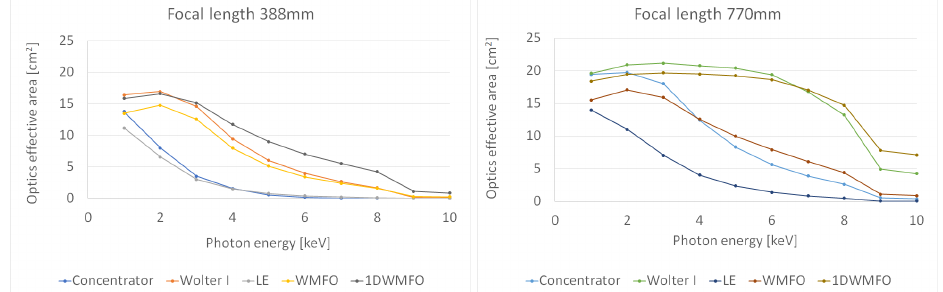
Figure 10. X-ray spectrometer optics effective area calculation for particular diameters relative to optical